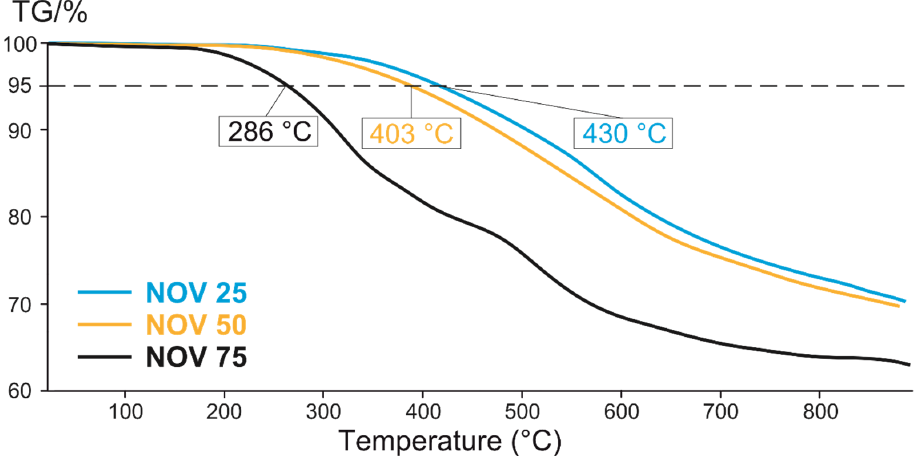
Figure 6. TGA curves for cured blends at 220 °C under nitrogen atmosphere.